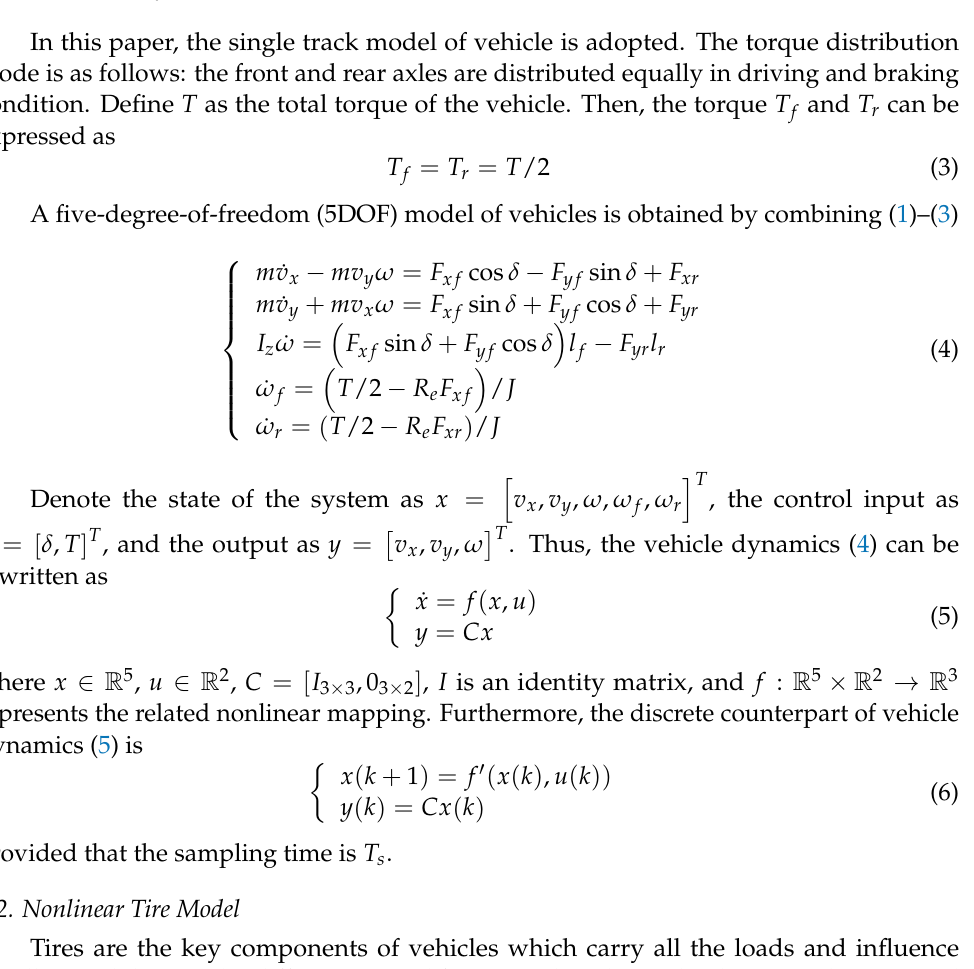
Figure 3. Wheel dynamics